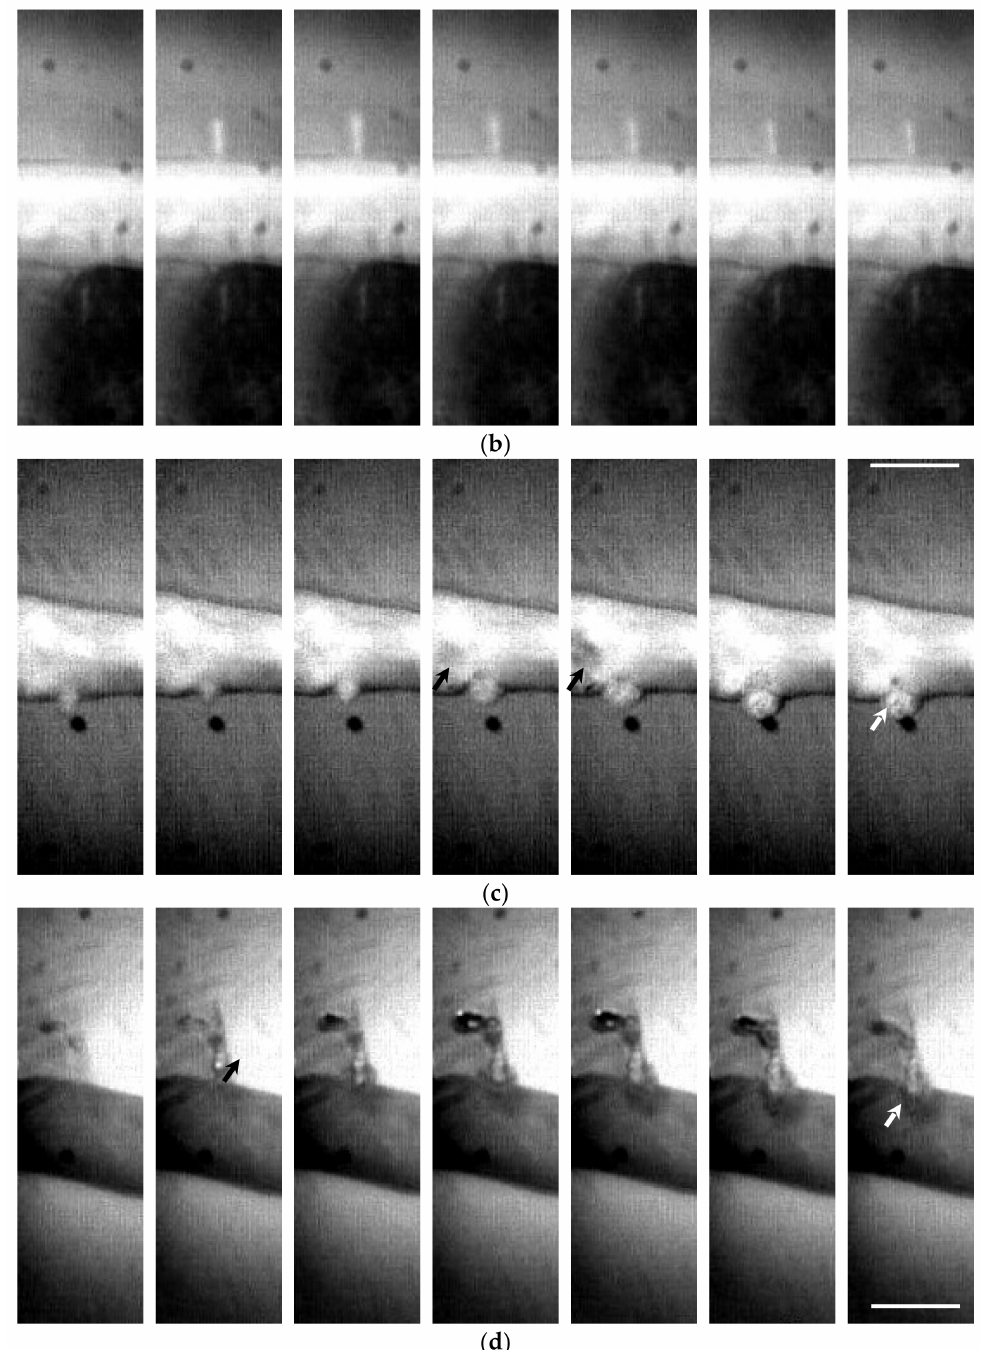
Figure 5. Representative high-speed images of HIFU exposure with its focus aligned to ( a ) the anterior artery wall by the 1st pulse, the middle of the artery by ( b ) the 4th pulse and ( c ) the 3rd pulse (different artery sample here), ( d ) the posterior wall by the 4th pulse. The arrowhead shows the significant interaction with the artery wall, the black arrow shows the motion of the HIFU-induced bubbles to the circulating fluid inside the artery sample, while the white arrow shows the lesion produced by the hydrodynamic cavitation. Scale bar represents 2